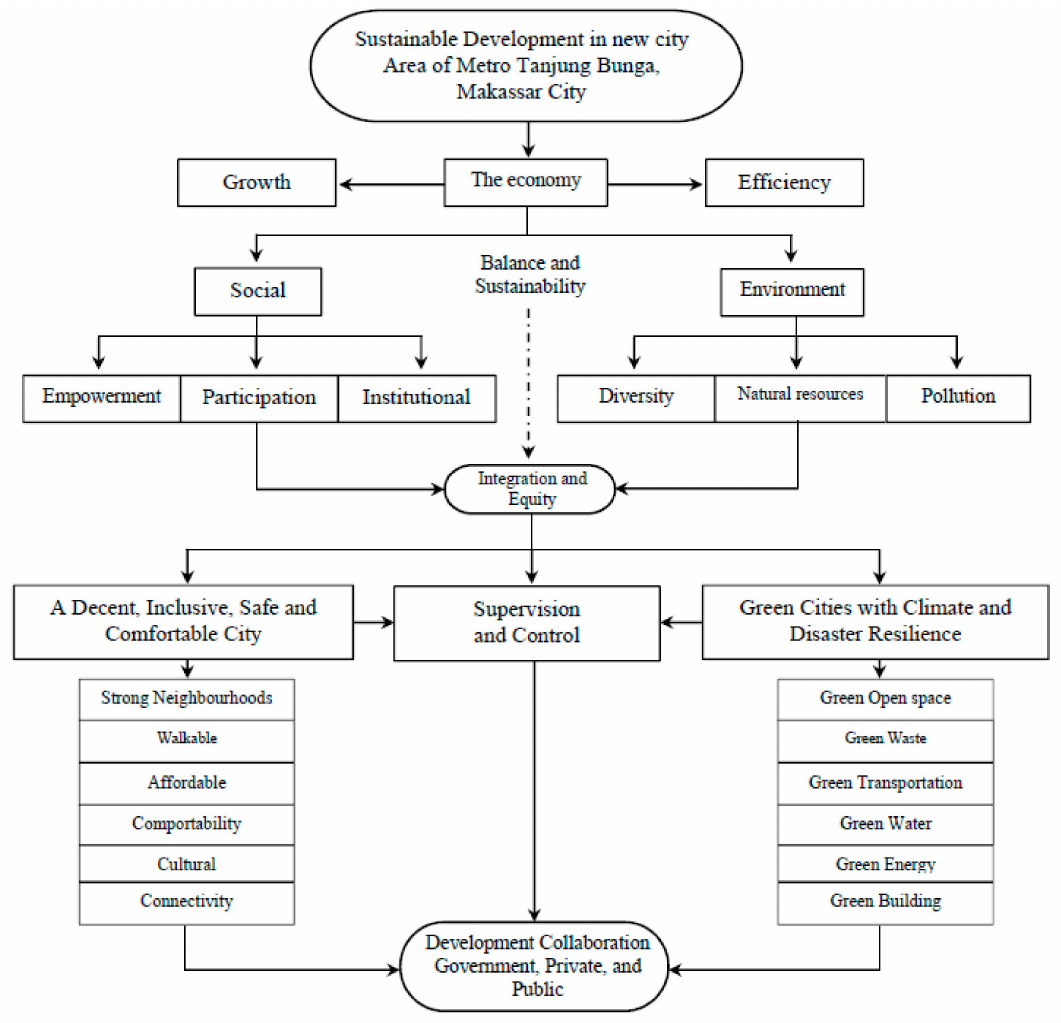
Figure 17. Sustainable development of the new city area of Metro Tanjung Bunga. Source: Author